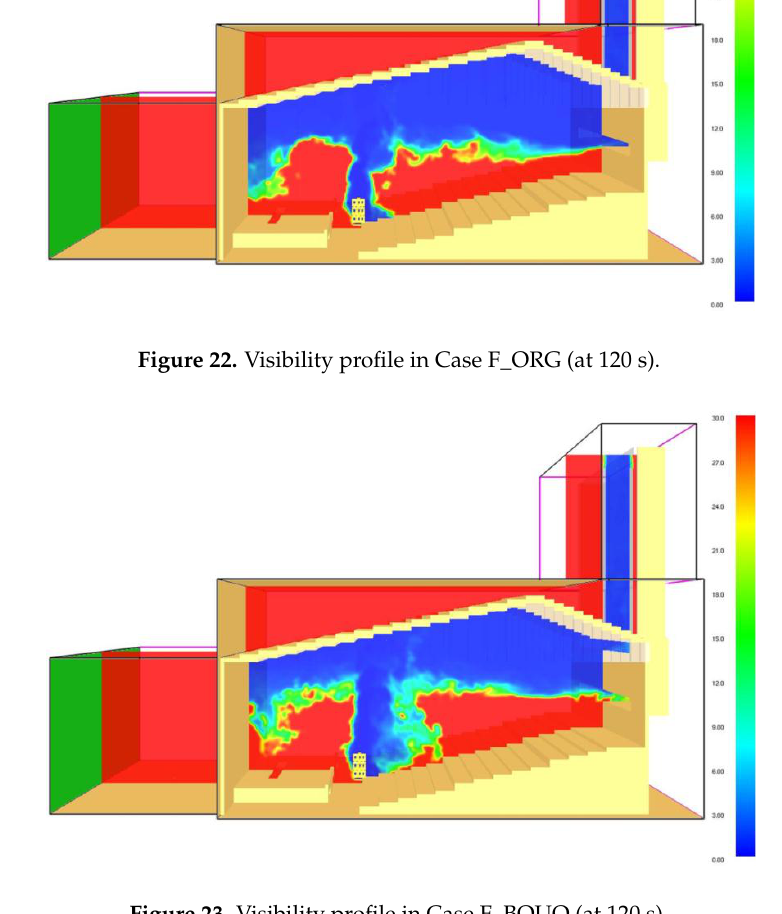
Figure 23. Visibility profile in Case F_BOUO (at 120 s).